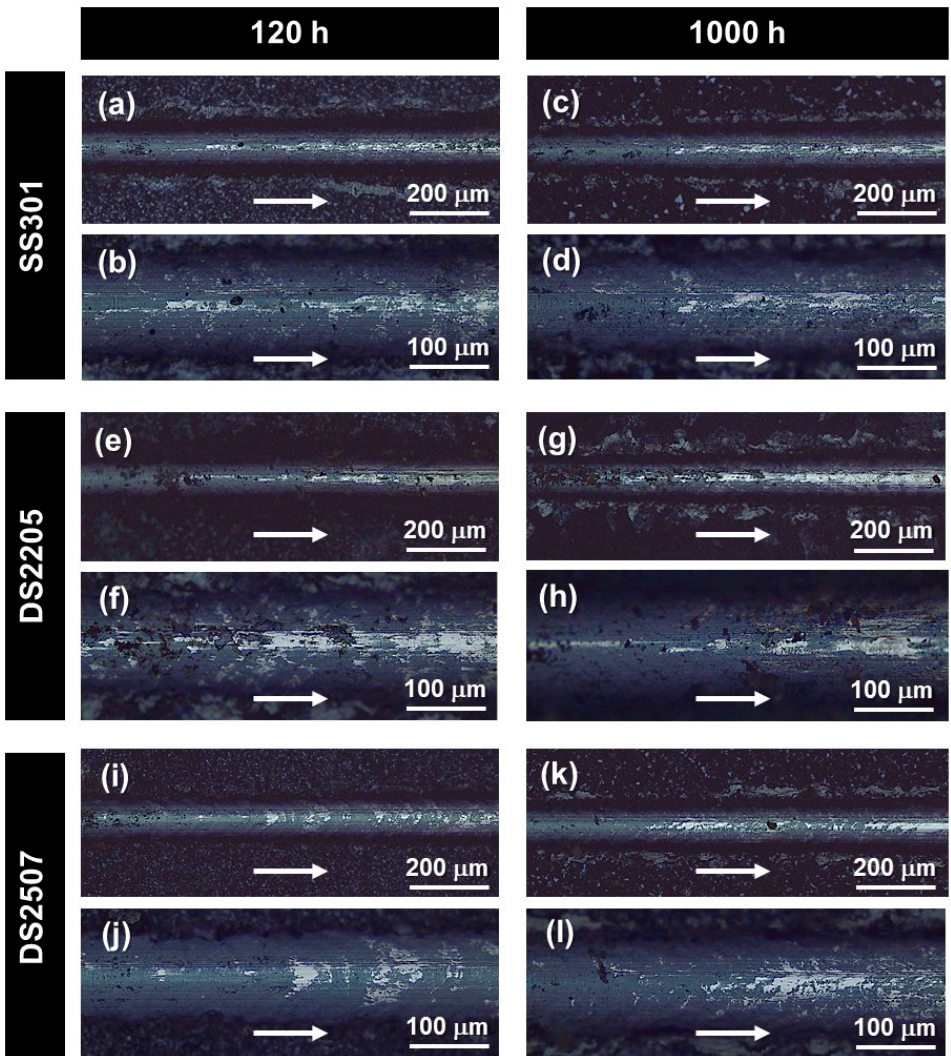
Figure 5. Optical microscopy images at two magnifications of scratch tracks on the oxide scale surface of ( a – d ) SS301, ( e – h ) DS2507 and ( i –l) DS2205 after 120 h and 1000 h. The white arrow indicates the indenter sliding direction during the scratch test.